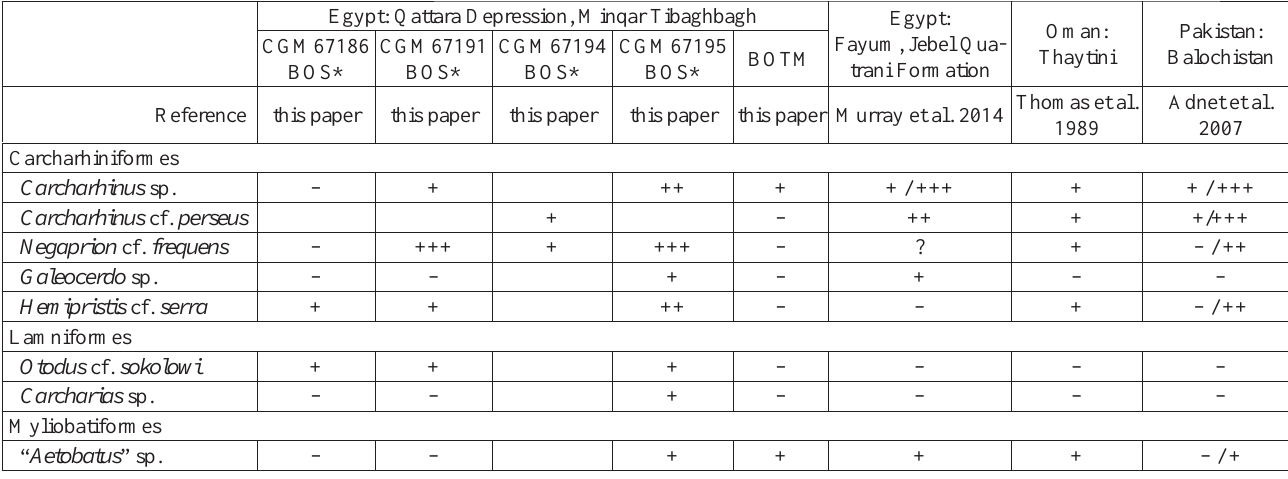
Table 5. Comparison of selachians from the BOTM and BOS, early Oligocene, Minqar Tibaghbagh, Qattara Depression, Egypt, with selachian faunas of the early Oligocene of Eastern Tethys Ocean. * Frequencies of the chondrichthyan species are only a rough estimation, as only a small number of teeth has been collected by surface prospecting. Abbreviations: –, absent; +–+++, rare–abundant; ?,